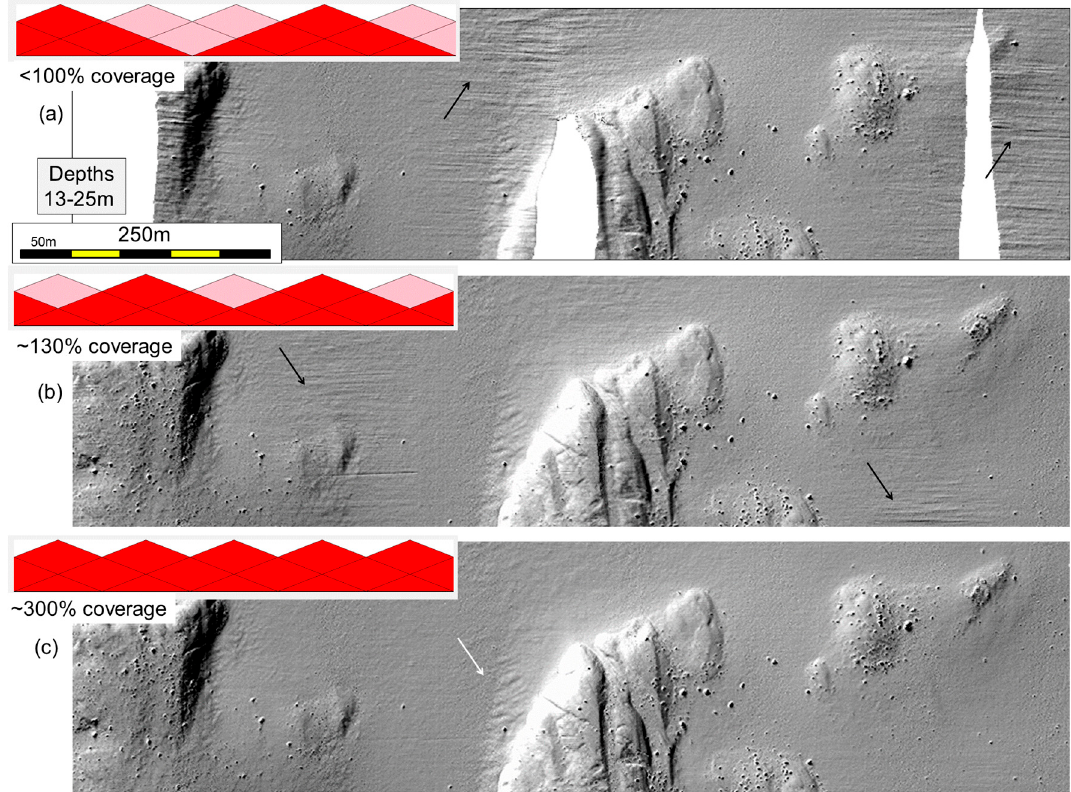
Figure 12. Impact of swath to swath overlap. Showing the manifestation of oceanographically driven instability in the outer part of a multibeam swath. ( a ) Full swath extent, including outer beam noise, revealed when <100% coverage is utilized; ( b ) partial suppression of the outer beam noise when ~30% overlap is used; ( c ) full suppression over artifact when ~300% overlap is used.